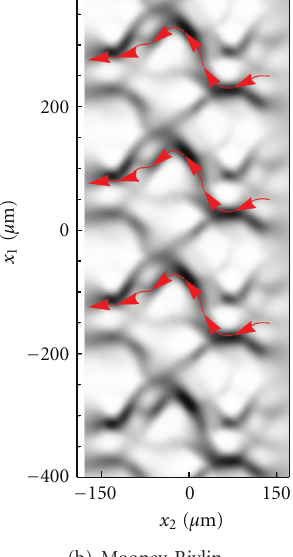
areas (black areas), occurring over a circumferential portion of the lip-shaft macroscopic contact domain. Results are shown at di ff erent values of dimensionless sliding velocity.